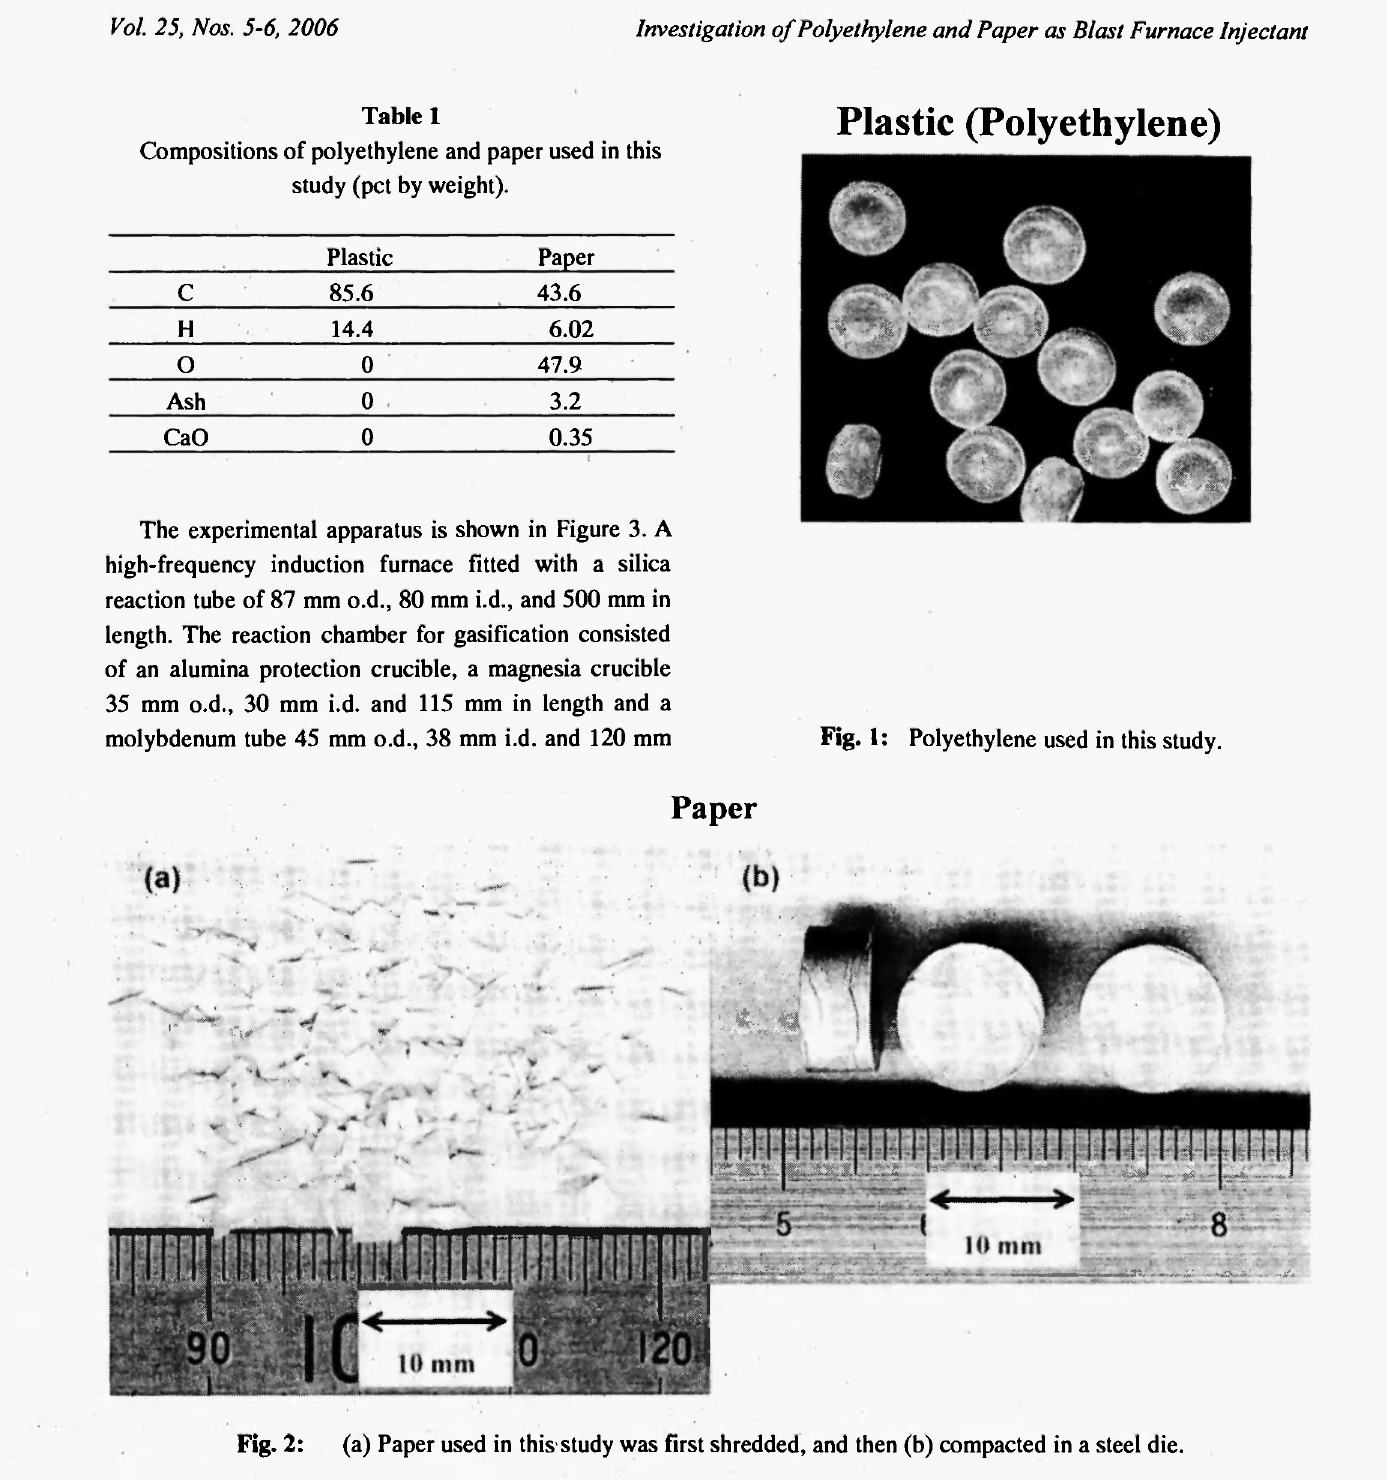
During this period the samples were positioned within a horizontal glass tube. After the temperature reached the placed desired value, the samples were charged into the reaction chamber, with the aid of a molybdenum push rod over a period of 14 minutes. About 6 g of samples were used for each run. The exhaust gas leaving